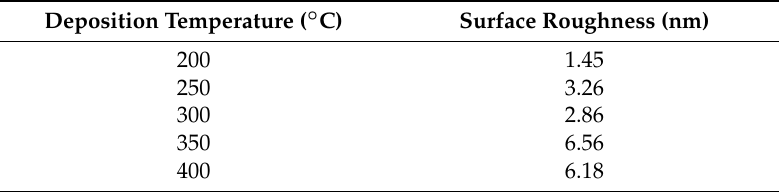
Figure 3. Atomic force microscope (AFM) images of TiO 2 films deposited under different temperatures using the mist CVD method (( a ) 200 °C; ( b ) 250 °C; ( c ) 300 °C; ( d ) 350 °C; ( e ) 400 °C). Table 3. The surface roughness (RMS values) of TiO 2